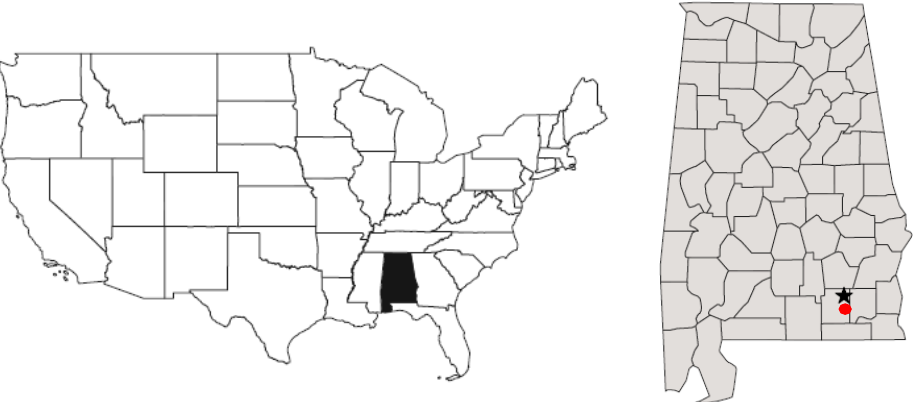
Figure 1. Location map showing location of the field site (star) (31.53° N and 85.87° W) and Enterprise, AL, weather station (circle) (31.33° N 85.85° W). Table 1. Summary details of soil series at the field